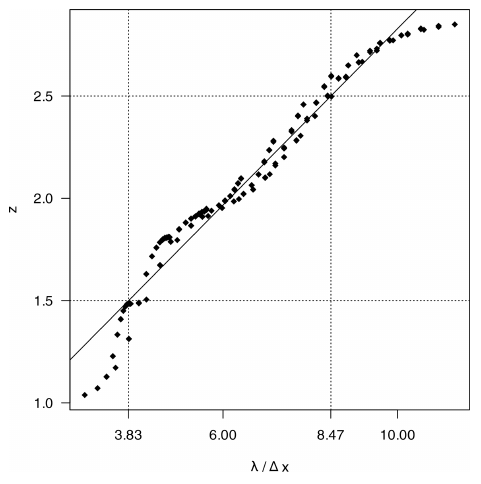
(cid:113) k 2 x + k 2 y against central scale z .